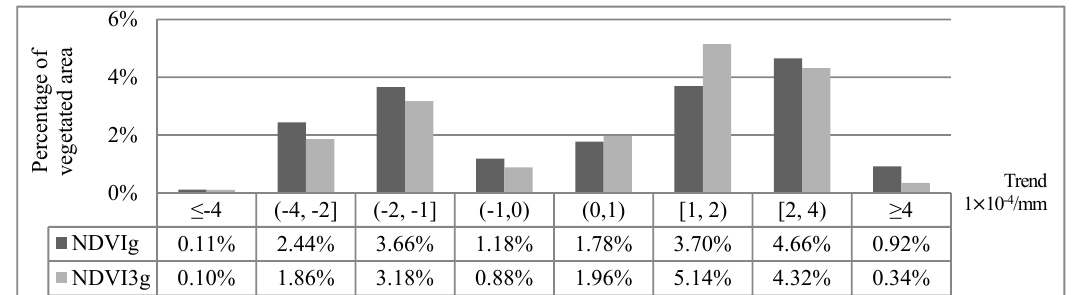
Figure 12. Frequency distribution for the response of growing-season NDVI to precipitation change ( P < 0.05) derived from different NDVI data sets.